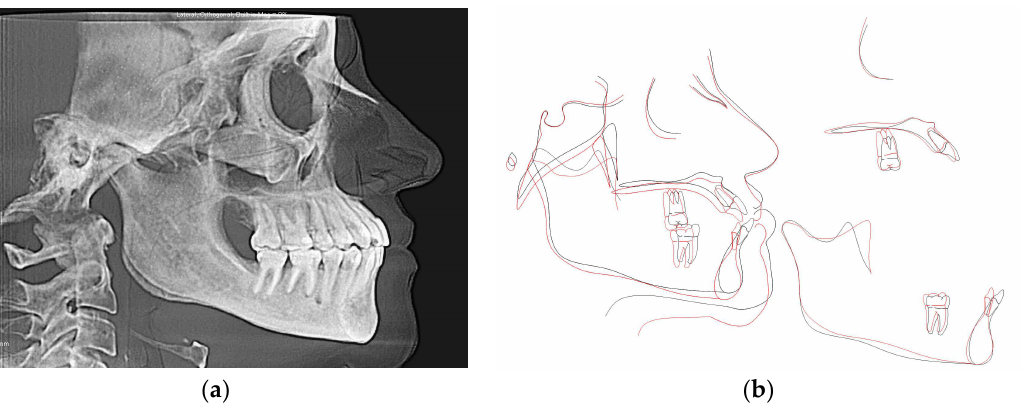
Figure 9. (a) Final CBCT-driven cephalometric radiograph and ( b ) cephalometric superimposition of before (black) and after (red) treatment cephalometric tracings showing improvement in the patient’s initial chief complaints including open bite and spacing as well as crossbite.